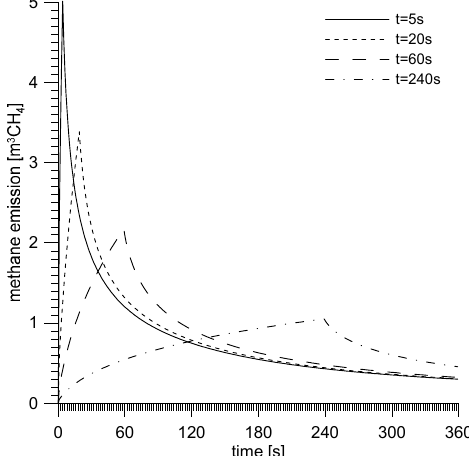
Figure 14. A model methane emission based on a sphere during the Zofiówka outburst.